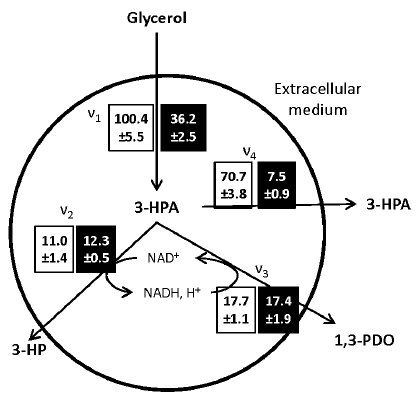
Figure 4. Metabolic fluxes (mmol · L − 1 · h − 1 ) through the glycerol bioconversion pathway in L. reuteri after growth on MRS (white boxes) or WE-LPS medium (black boxes). Mean values of three replicates.